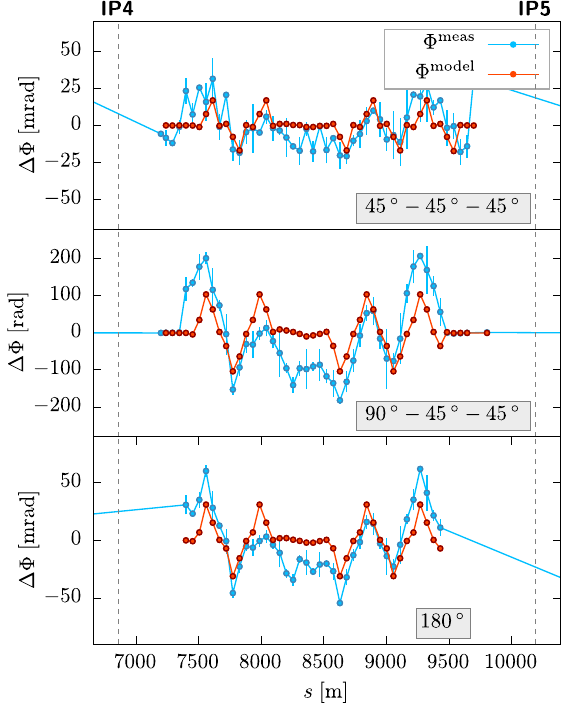
FIG. 10. Plot of measurement data of the LHC commissioning 2018 at β (cid:3) ¼ 30 cm. The error bars include statistical errors obtained from the phase measurement of the FFT. The effect of dispersion bumps on the local observable is clearly visible and matches well the prediction. The center region shows only a small effect from